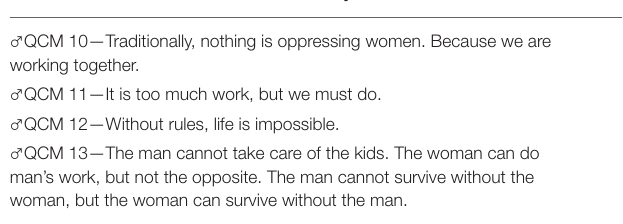
TABLE 4 | Perceptions on traditions in